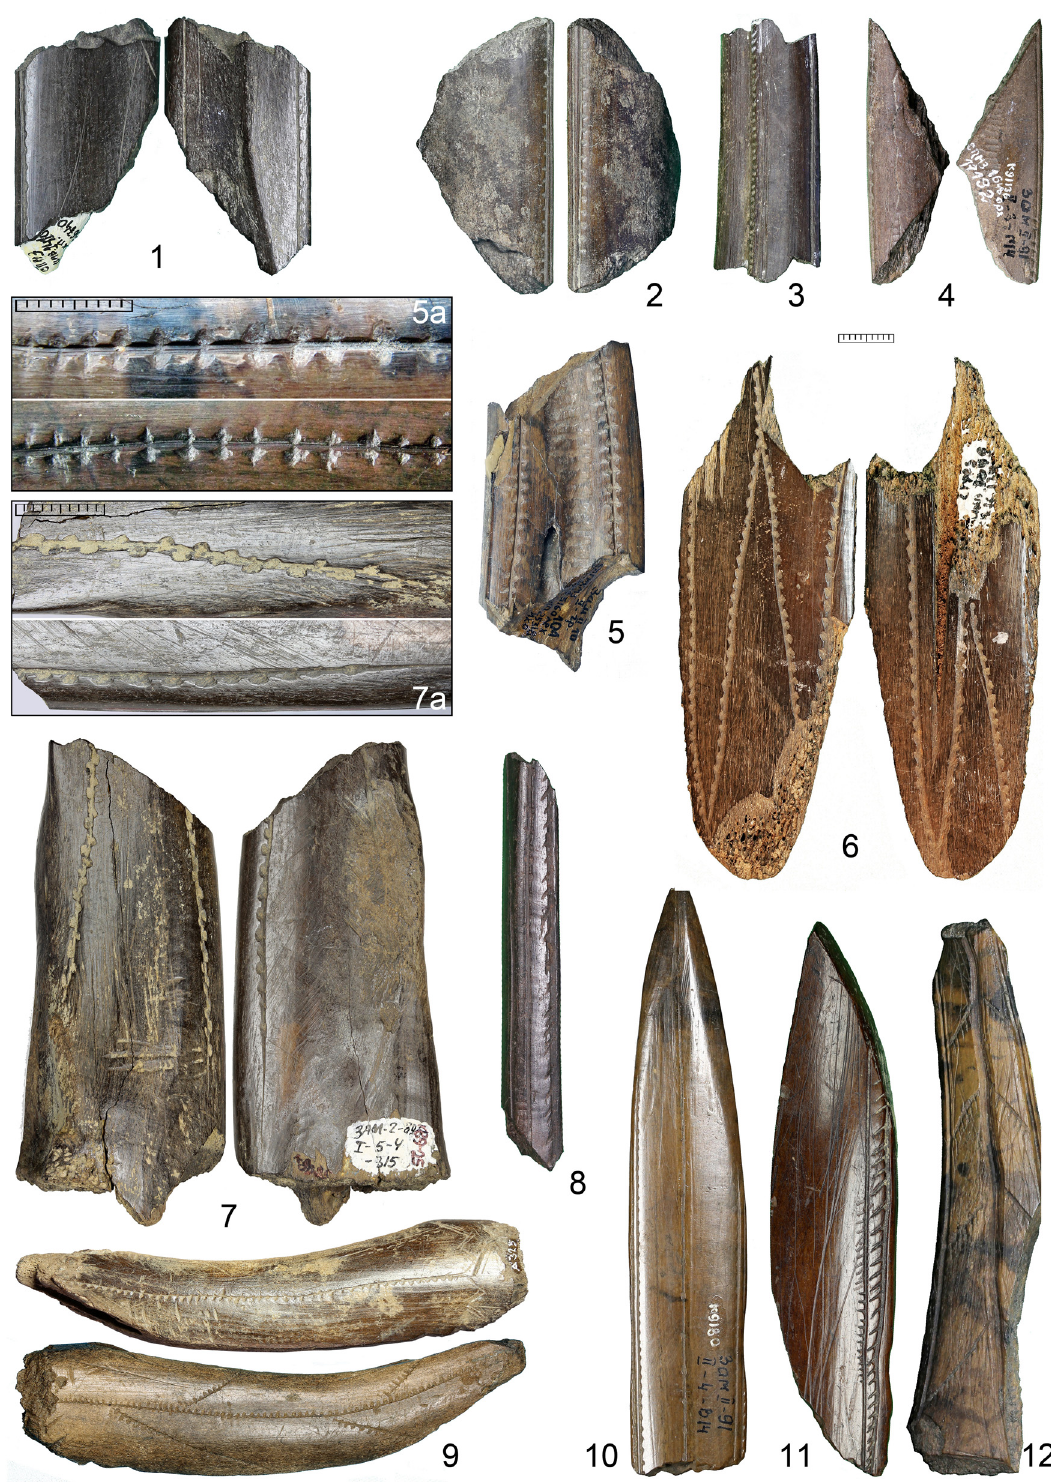
Figure 10: Zamostje 2. ( 1 – 4, 6 – 8, 12 ) Tool fragments; ( 5 ) slotted dagger; ( 9 ) slotted sickle - shaped tool; ( 10 ) dagger ( knife ) ; ( 11 ) beveled